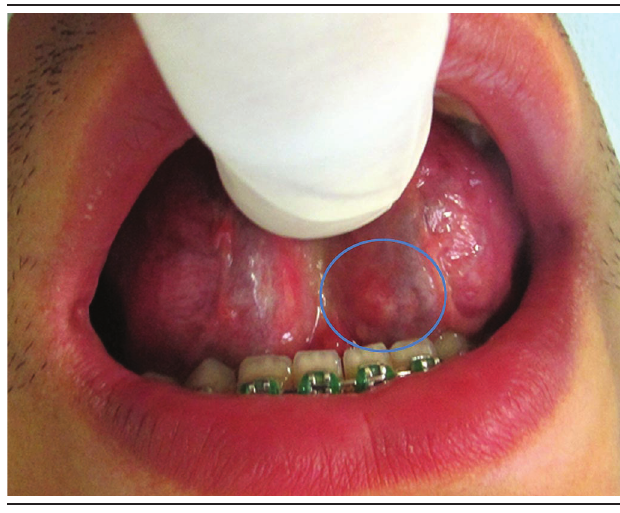
figurE 1 − Clinical aspect of OLEC Nodular lesion, in the ventral surface of the tongue, yellowish, slow and submucosal growing, measuring approximately 0.5 cm. OLEC: oral lymphoepithelial cyst.